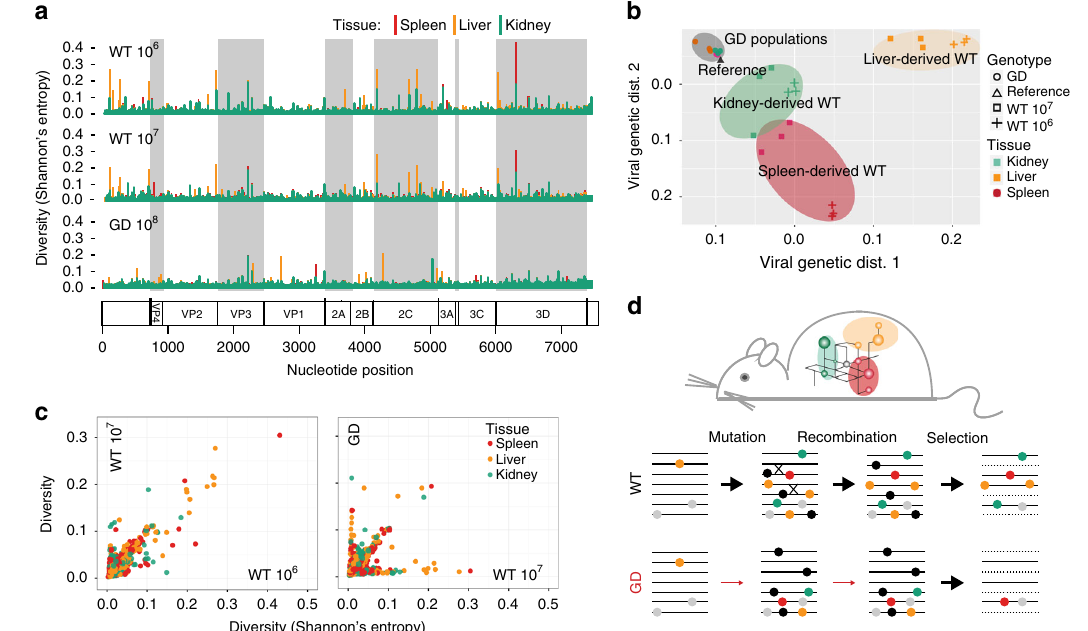
Fig. 4 Genetic composition of poliovirus promotes intrahost evolution through counteracting tissue speci fi c interferon responses. a Tissue-speci fi c patterns of diversity in organ-resident populations. Virus was isolated at 3 days postinfection in Tg21 mice ( n = 3, the number of mice is three for each time point and each group). Liver (LV), kidney (KD), and spleen (SP). Diversity is represented as Shannon ’ s Entropy. b The genetic structures of in vivo adapted populations. Multidimensional scaling correlation. In vivo adaptation leads to tissue-speci fi c genetic structures ( colored ovals ) in WT populations from LV, KD and SP, but not in GD populations ( grey oval ). c Correlation plot of diversity between tissue-speci fi c adapted populations between viral strains. d Model highlighting how ef fi cient recombination and mutation leads to rapid adaptation during intrahost spread. G64S/D79H(GD), engineered to be de fi cient in recombination and diversity, is limited in its ability to rapidly adapt to changing selection